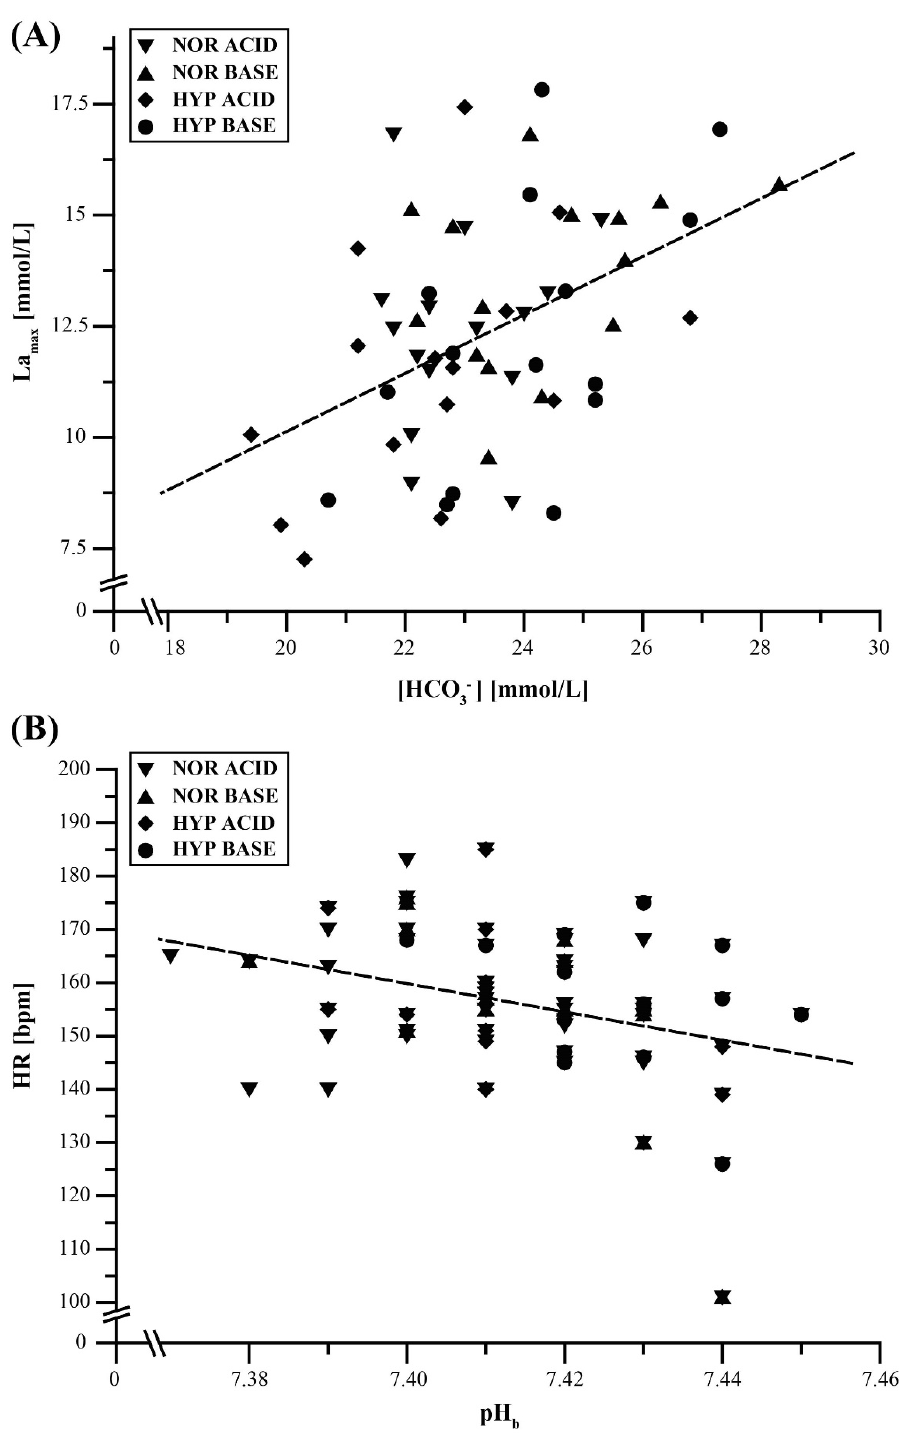
Figure 4. Relationships between PTSR-related ( A ) maximum post-exercise lactate concentration (La max ) and ( B ) heart rate (HR) and the blood gas measurements before PTSR tests of blood pH (pH b PRE PTSR) and blood bicarbonate ([HCO 3 − ] PRE PTSR). Data points represent individual values for the four treatment conditions NOR ACID ( n = 15), NOR BASE ( n = 15), HYP ACID ( n = 15), and HYP BASE ( n = 15). NOR = normoxia, HYP = hypoxia, ACID = acidizing diet, and BASE = alkalinizing diet. See Section 2. Materials and Methods for further details.